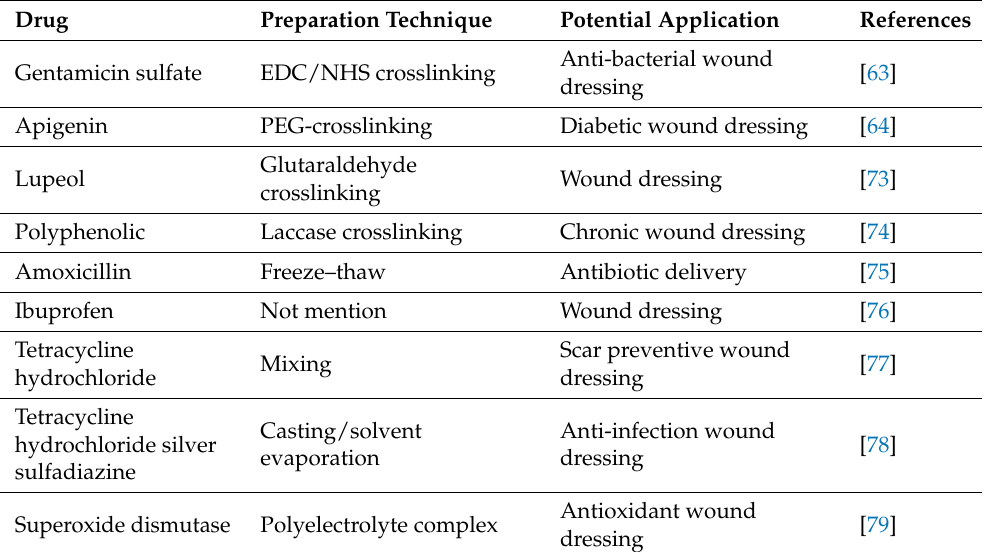
Table 3. Summary of the application of drug-loaded chitosan hydrogels. Drug Preparation